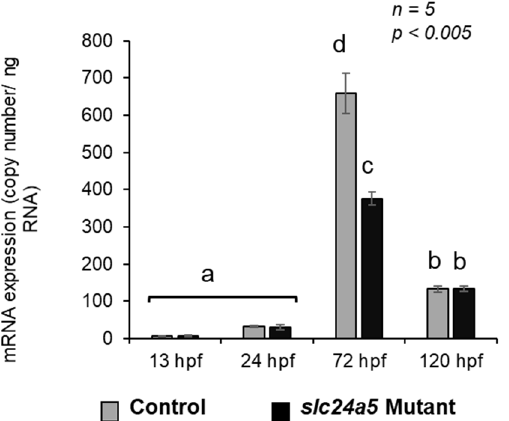
Figure 10. slc24a5 mRNA expression analysis in control and slc24a5 mutants at different developmental time points (13–120 hpf) of kawakawa embryos using quantitative real-time PCR. Data are mean ± SEM from four developmental stages, with three replicates each. Letters (a–d) on the top of the bar indicate significant differences ( p < 0.005) between control and the TALEN-induced mutant slc24a5 expression. The absolute quantification of the slc24a5 transcript in the TALEN mutant was significantly different from that of the control embryos only at 72 hpf. hpf: hours post